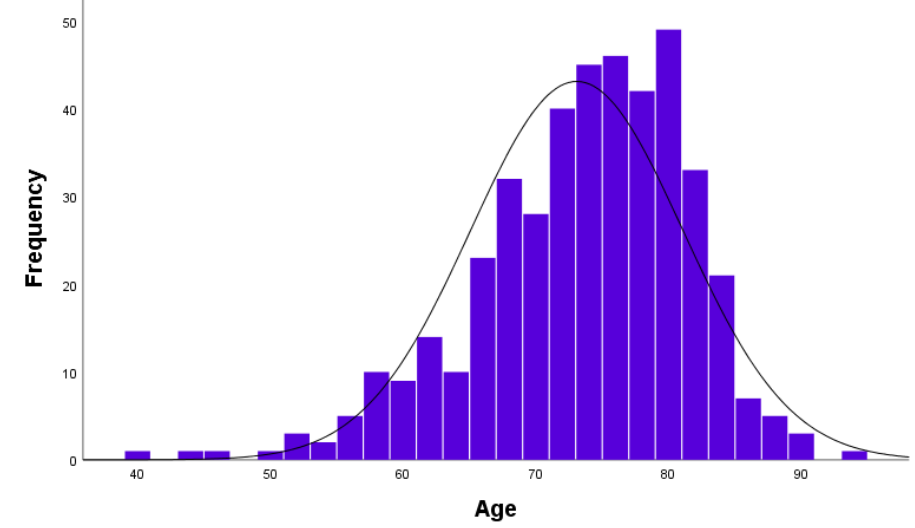
Figure 1. Age distribution in histogram.